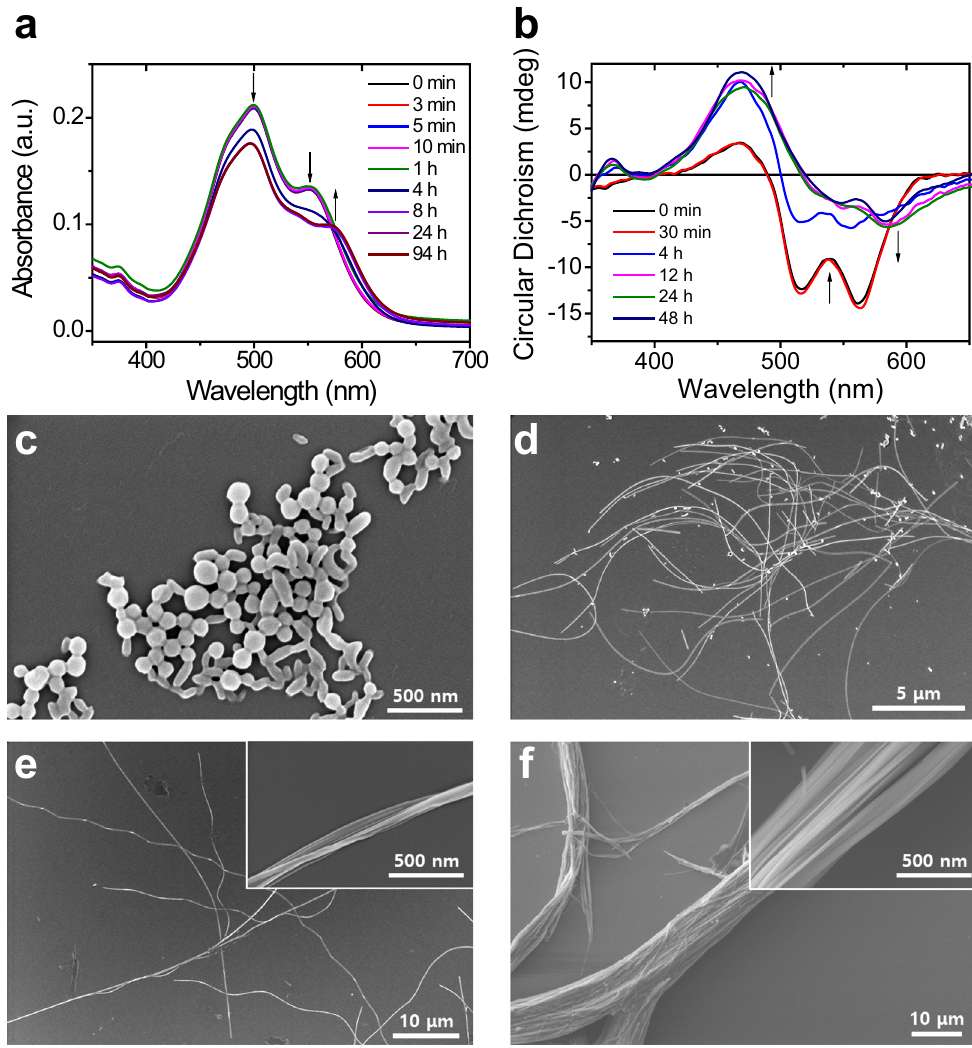
Figure 3. ( a ) Time-dependent UV-vis and ( b ) CD spectra of ( S )-CPDI-Ph in THF/water mixed solution (1.0 × 10 − 5 M) with f w = 80%. Time-dependent SEM images of ( S )-CPDI-Ph in THF/water mixed solution